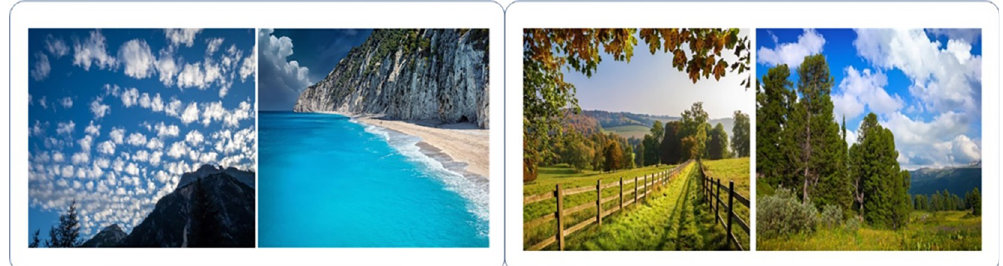
Fig 1. Images having similar visual appearance but belongs to different classes [3] (reprinted from [3] under a CC BY license, with permission from J. Z. WANG, original copyright [2003]).